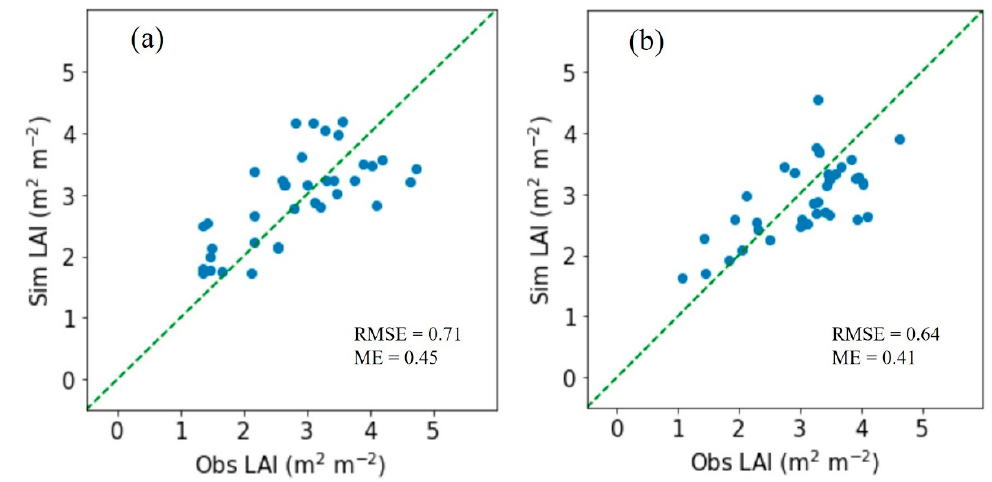
chine, and Extreme Gradient Boosting models.